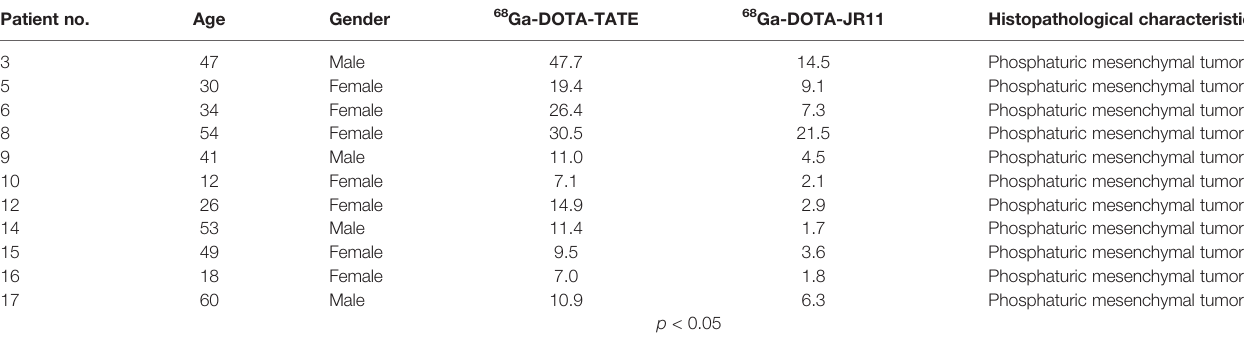
TABLE 2 | Clinical features of TIO patients, including histopathological characteristics and SUVmax of the responsible tumor of TIO. Patient